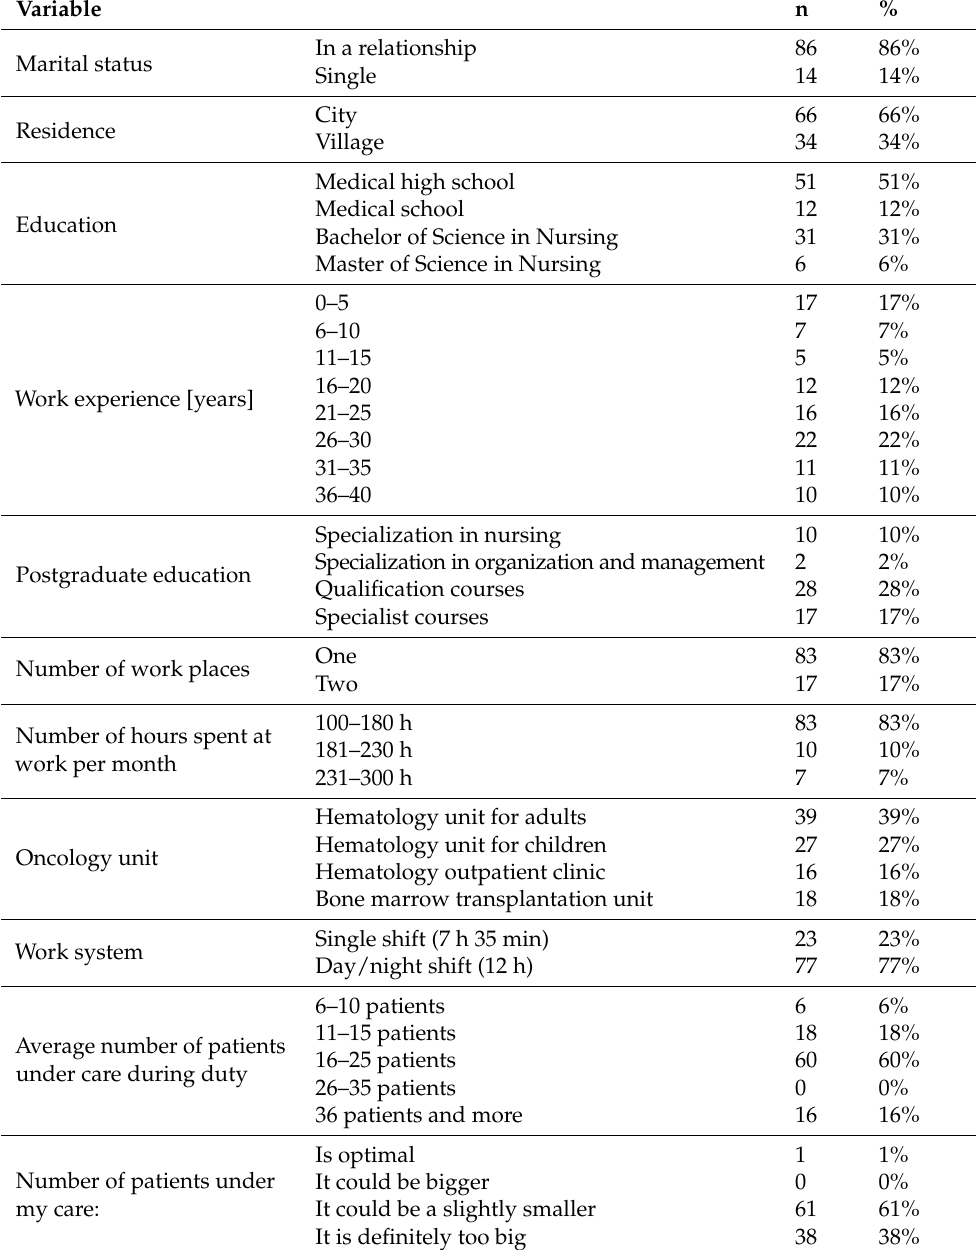
Table 1. Thee sociodemographic characteristics of the study group of oncology nurses (n = 100).